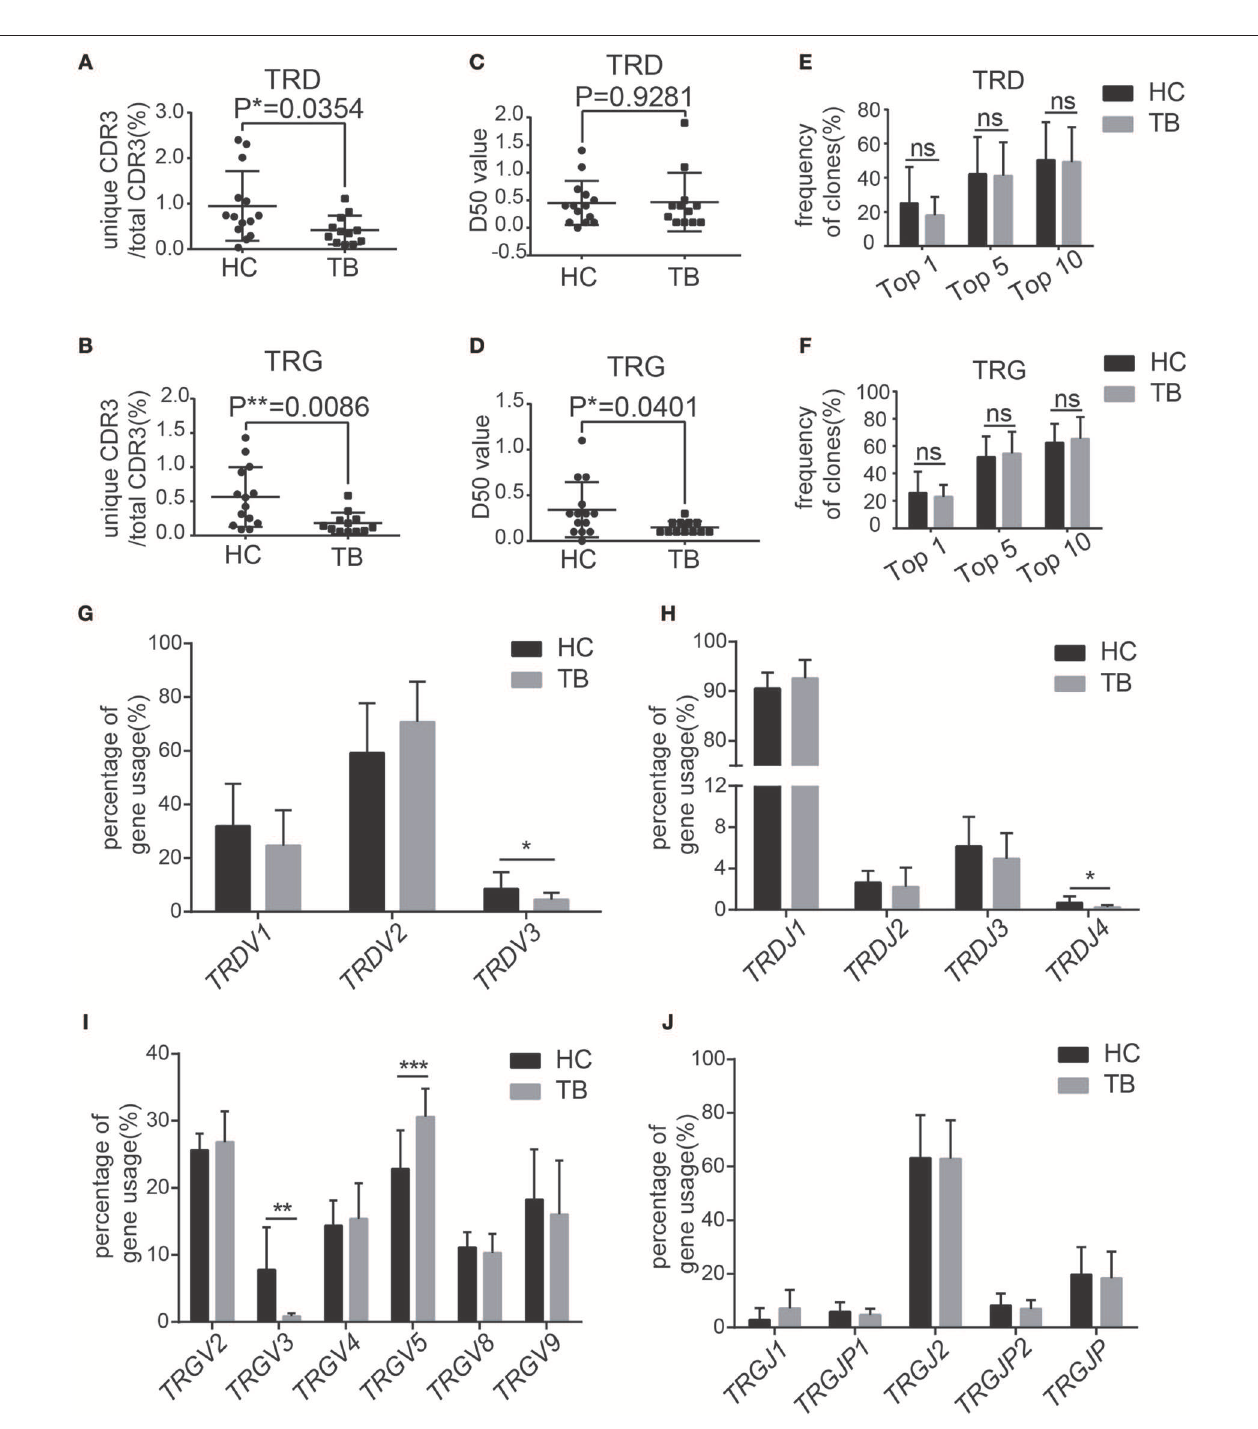
FIGURE 2 | TB patients showed different characteristics of the immune repertoire of γδ T cells. (A,B) Quantification of the ratios of unique CDR3/total CDR3 of the δ (A) and γ (B) chains in the CDR3 region. (C,D) Quantification of the D50 values of the δ (C) and γ (D) chains in the CDR3 region. (E,F) Frequencies of the top 1, top 5, and top 10 CDR3 sequences of the δ (E) and γ (F) chains in the CDR3 region. (G,H) The germline gene usage of T-cell receptor δ -chain (TRD) V fragments ( TRDV1 , TRDV2 , TRDV3 ) and J fragments ( TRDJ1 , TRDJ2 , TRDJ3 , TRDJ4 ). (I,J) The germline gene usage of T-cell receptor γ -chain (TRG) V fragments ( TRGV2 , TRGV3 , TRGV4 , TRGV5 , TRGV8 , TRGV9 ) and J fragments ( TRGJ1 , TRGJ2 , TRGJP , TRGJP1 , TRGJP2 ). Data represent the mean ± SD. * P < 0.05, ** P < 0.01, *** P < 0.001 by Student’s t test.